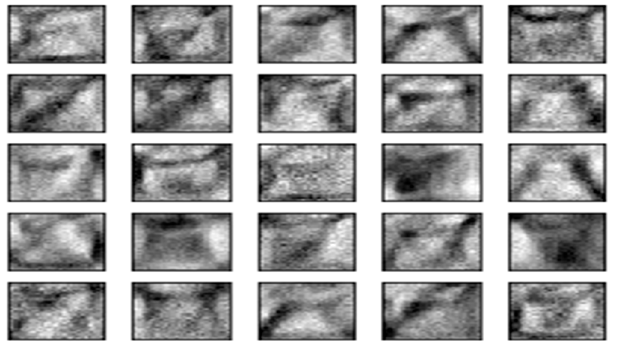
Figure 3. RBM feature map.